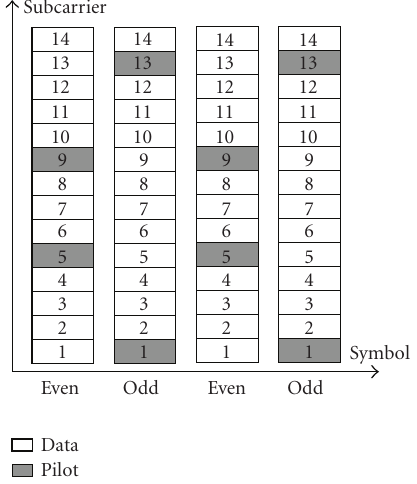
Figure 4: Pilot pattern of data symbol in a cluster.